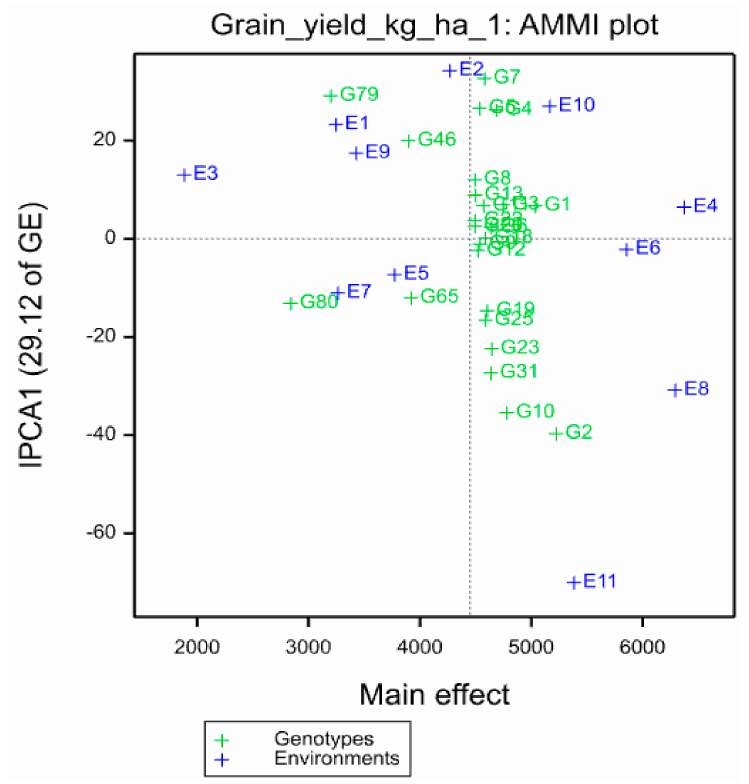
Figure 1. AMMI Biplot for grain of 24 maize hybrids showing genotypes and environments (E1-E11) plotted against their IPCA1 scores. (Codes for environments in Table